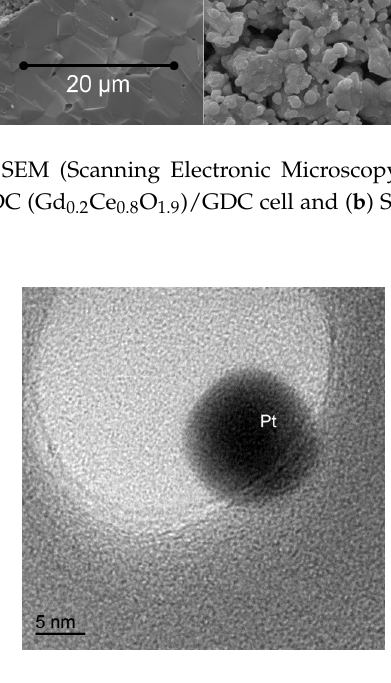
Figure 1. ( a ) Cross section SEM (Scanning Electronic Microscopy) image of the Pt ‐ BaO/LSCF (La 0.6 Sr 0.4 Co 0.8 Fe 0.2 O 3 −δ ) ‐ GDC (Gd 0.2 Ce 0.8 O 1.9 )/GDC cell and ( b ) SEM image of the surface of the catalyst ‐ electrode.